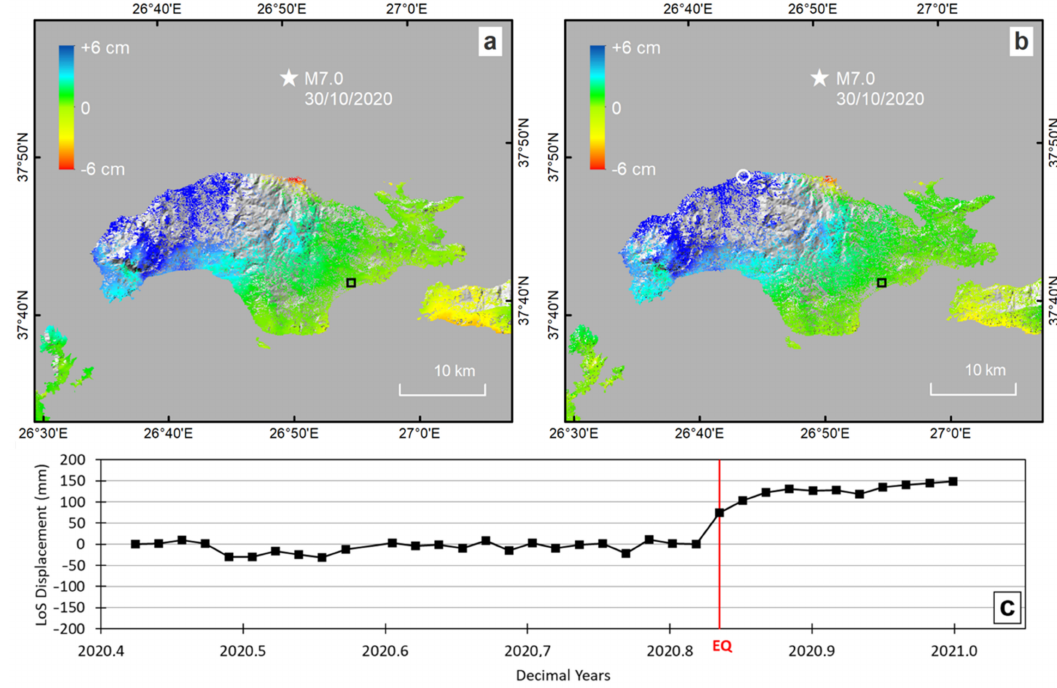
Figure 16. ( a ) Co-seismic Sentinel-1 differential interferogram (24 October 2020–30 October 2020; ascending track 131) for the Samos M7.0 earthquake-based P-SBAS service (in IFG mode) at 100 m resolution (unwrapped and converted to LoS displacements) and ( b ) corresponding displacements as extracted from SNAPPING PSI time series at medium resolution. SNAPPING point measurements are averaged to 100 m grid for consistent representation among the techniques. The selected reference area is marked (black square). PSI time series ( c ) of a point target located within the co-seismically uplifted region (white circle in ( b )) is also shown. Contains modified Copernicus Sentinel-1 mission data (2020), processed by AUTh on